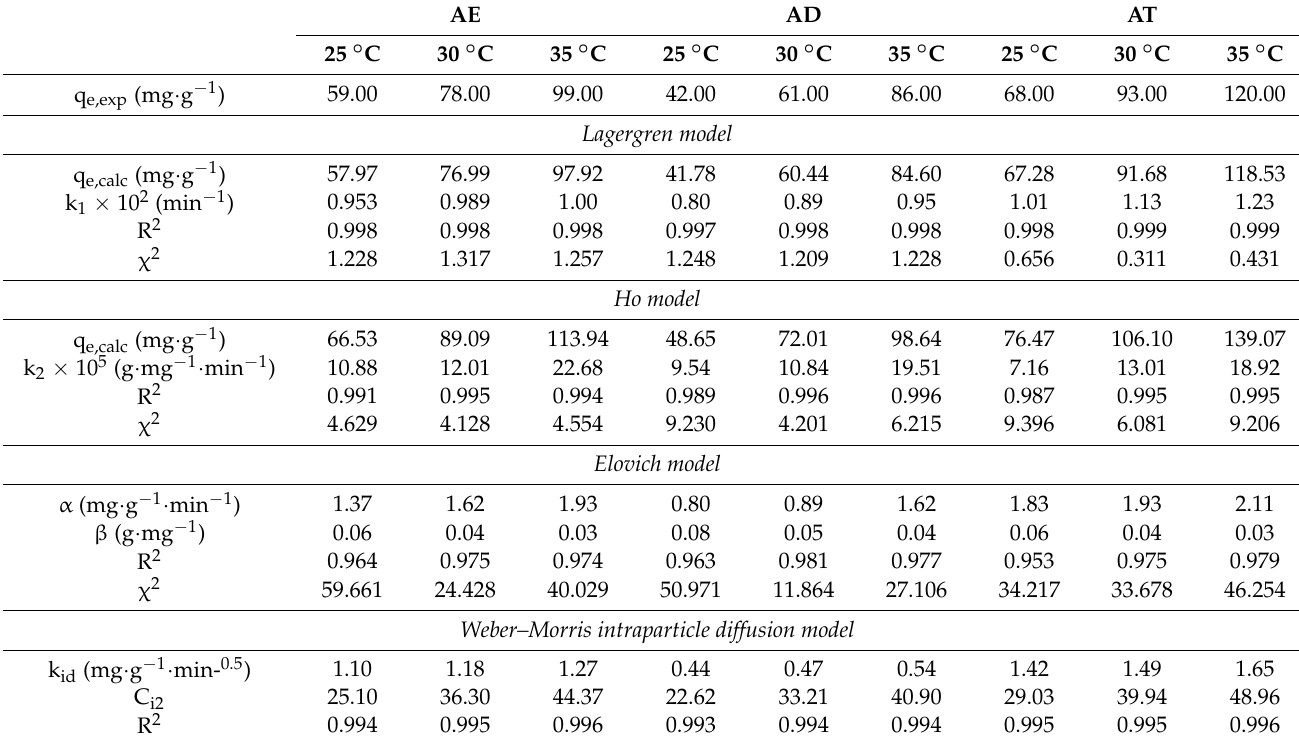
Table 10. Kinetic parameters for adsorption of metronidazole onto AE, AD and AT microparticles.